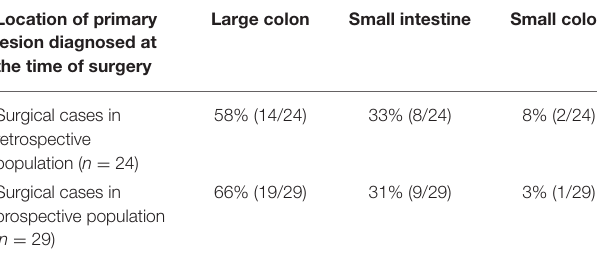
TABLE 3 | Location of primary lesion diagnosed at the time of surgery in retrospective and prospective